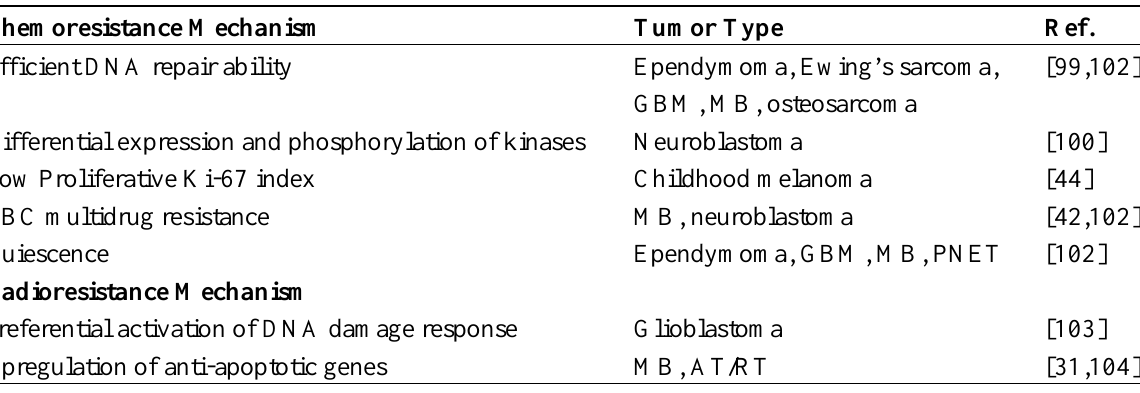
Table 3. Putative mechanisms of chemoresistance and radioresistance of pediatric tumor stem cells (TSC). MB,